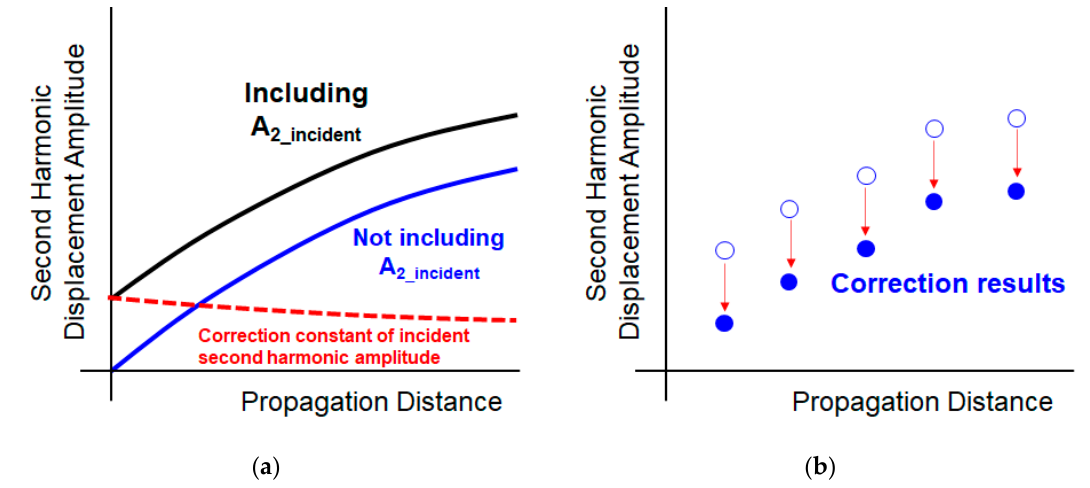
Figure 9. Estimation of the second harmonic displacement amplitude ( A 2 ( z ) ) for p 2 equal to 0 in a negative phase, also indicating a relationship to Figure 7b.